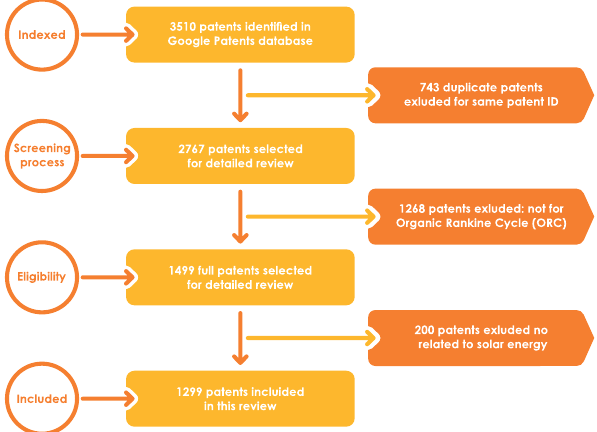
Figure 3. Process adopted to review patents results based on